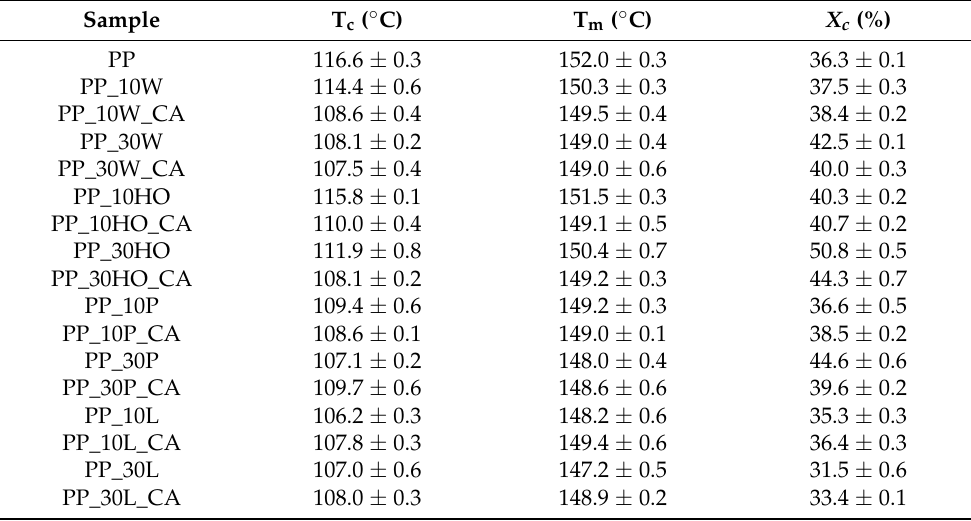
Table 5. Thermal properties of composites obtained from DSC analysis.